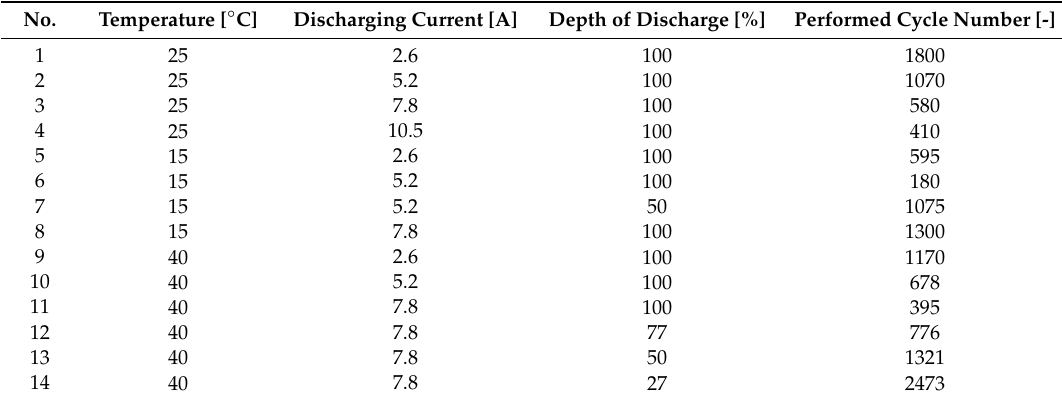
Table 2. Values of cyclic operating parameters of tested cell selected during aging tests.